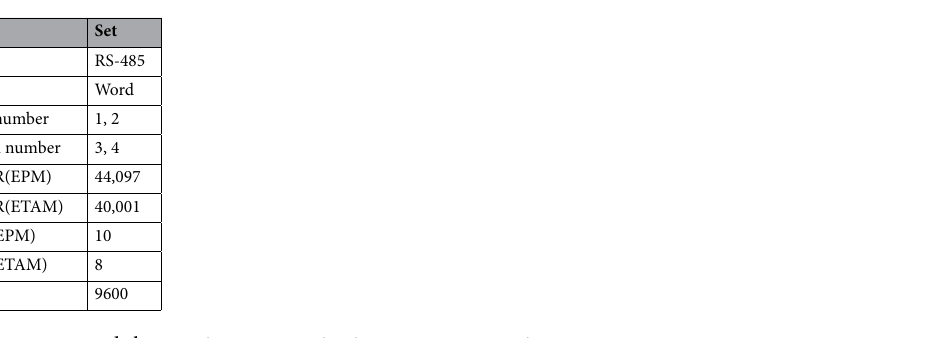
Table 2. The master and slave station communication parameters setting.